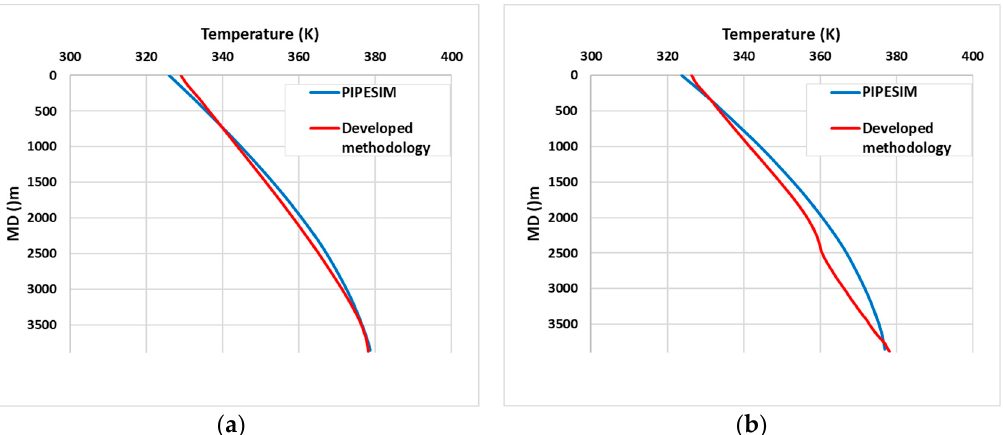
Figure 8. Borehole wall temperature distribution along the wellbore. The blue line represents the result of PIPESIM calculation, while the red line represents the result of calculation of the proposed model. The black oil model is ( a ), while the compositional model is ( b ).